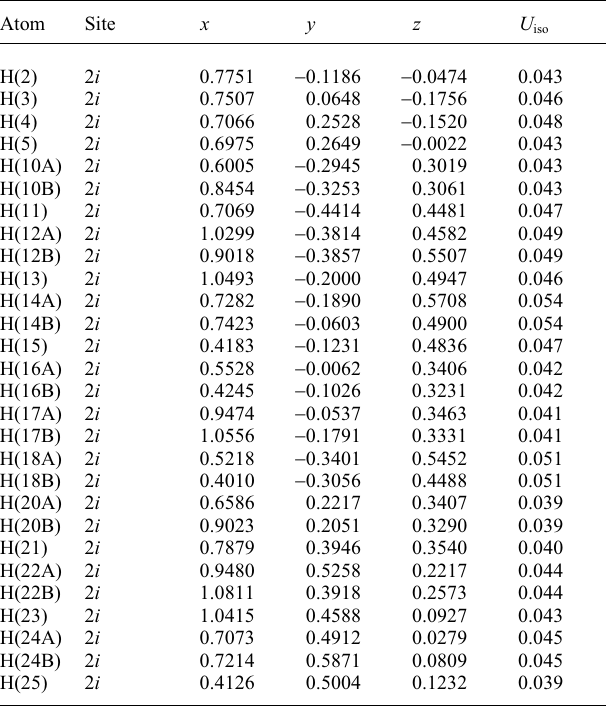
isoindoline ring is almost planar. The dihedral angle between the indicate that both N1 and N2 atoms are sp 2 -hybridized. The mole- cules are stacked in columns along the a axis with successive molecules oriented in opposite directions. In the columns, & - & in- teractions between the aromatic rings may be present. For Cg1 (the centroid of ring C1-C6) and Cg1 i (symmetry code i: 2-x,-y,- z), the centroid-centroid distance is 3.618(2) Å, the planes are parallel and shifted by 1.508 Å. For Cg1 and Cg2 i (the centroid of ring N1-C8), the centroid-centroid distance is 3.708(2) Å, and the dihedral angle between the ring planes is 1.84(2)°. Table 2. Atomic coordinates and displacement parameters (in Å 2 )